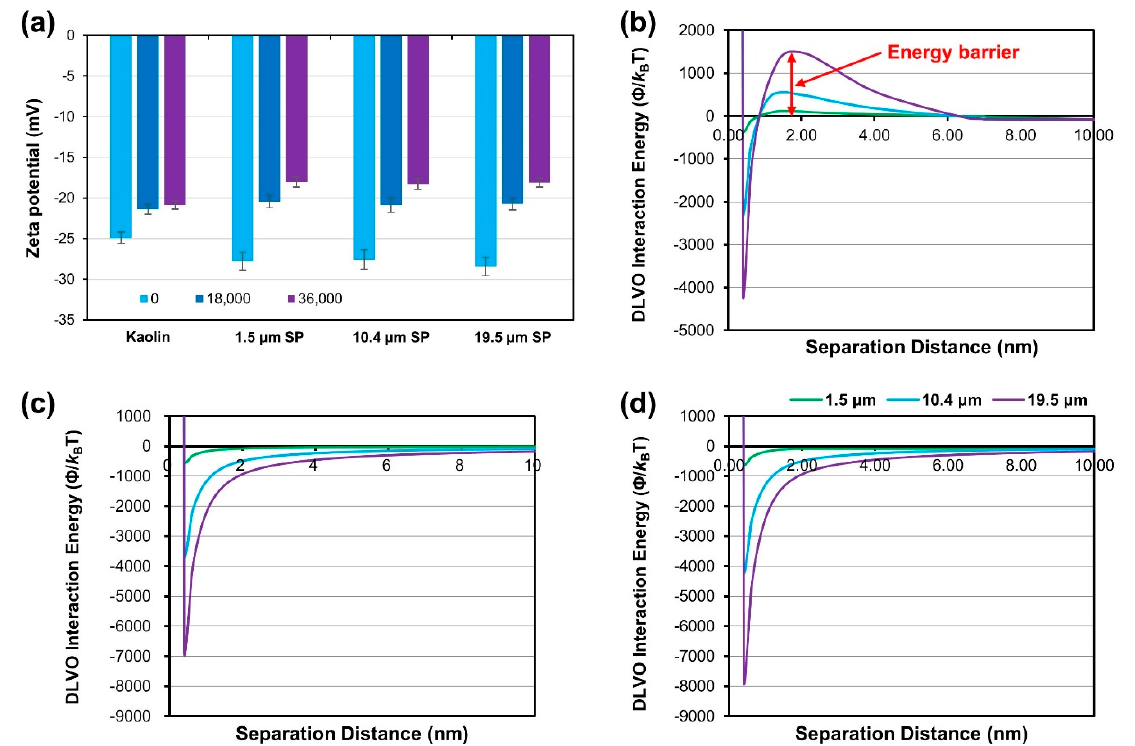
Figure 9. Zeta potential of SP and Derjaguin, Landau, Verwey, and Overbeek (DLVO) interaction energy curves between filter media material and SP: ( a ) zeta potential of SP; ( b ) DLVO interaction energy curves for an ion concentration of 0 mg/L; ( c ) 18,000 mg/L; and ( d ) 36,000 mg/L.